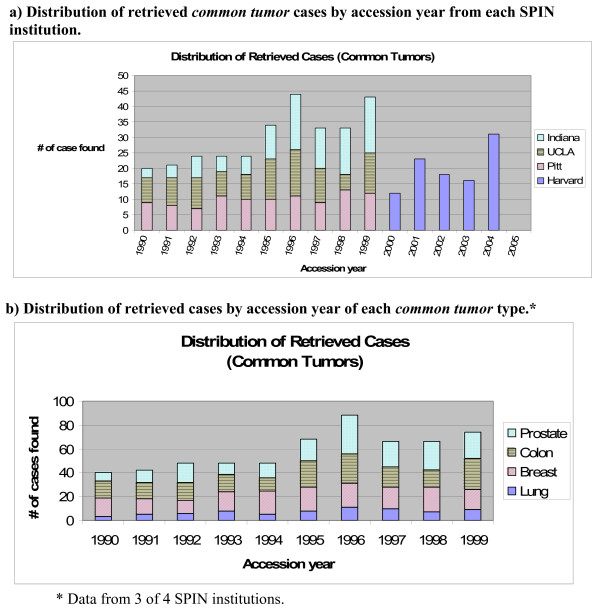
Distribution of retrieved cases for the common tumors. Illustration of number of cases retrieved for common tumor cases by the original year of accession: (a) Breakdown by each institution and (b) by common tumor type*. Specimens retrieved and evaluated for the common tumors encompassed cases accessioned range from 1990–1999 with 64% being at least 10 years old.